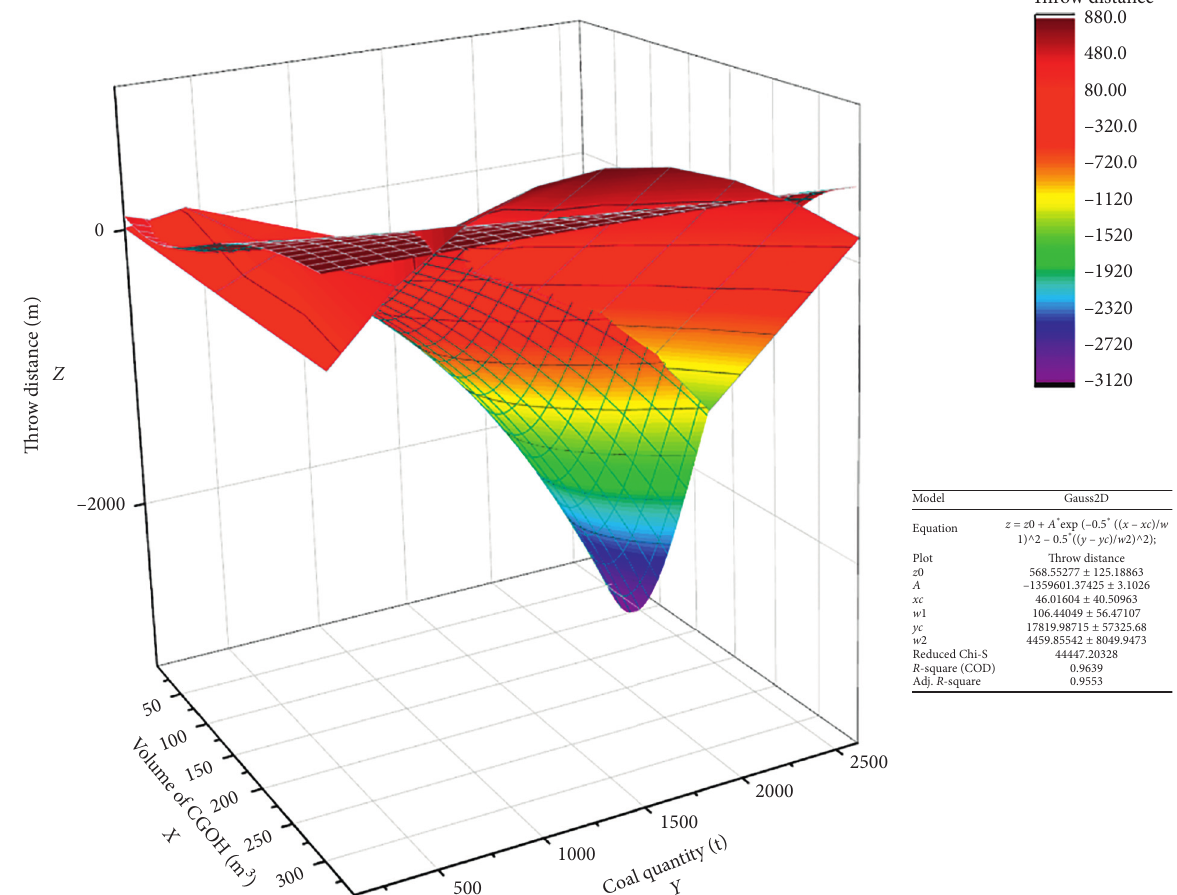
Figure 20: 3D color surface map of hole parameters and its nonlinear surface fit